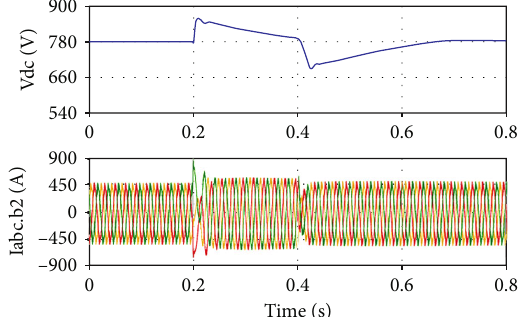
Figure 17: DC-link voltage and the three-phase currents during